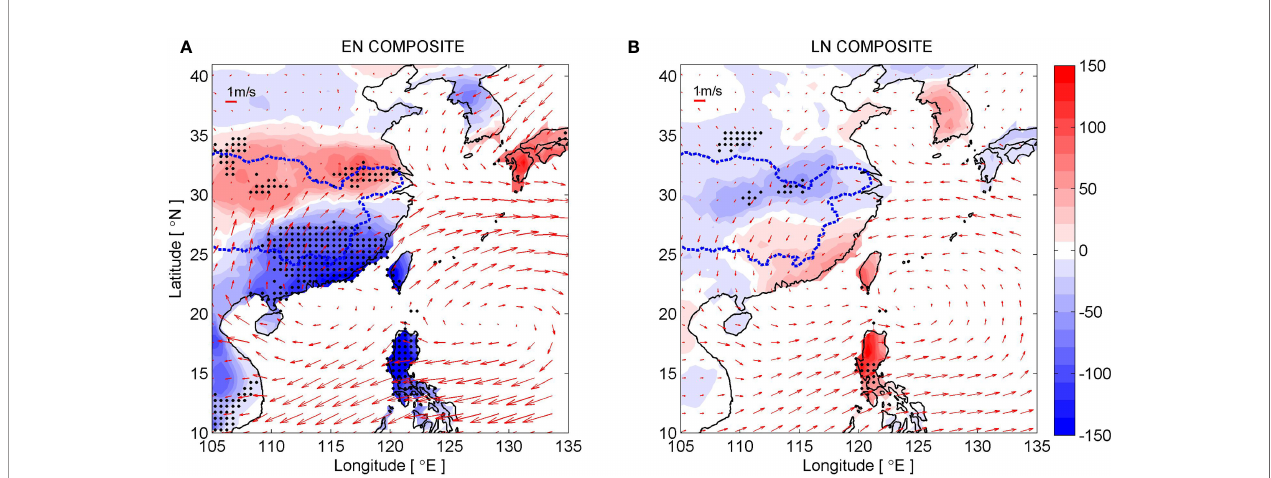
FIGURE 7 | (A) Composite difference of land-based precipitation (color) in July for fi ve El Niño years (1998, 2003, 2005, 2007, and 2010) and the climatology mean. Red arrows denote composite difference of surface wind between El Niño years and climatology mean. Stippling indicates that the differences are statistically signi fi cant at the 95% level. The region bounded by a thick blue dashed line denotes the Changjiang river catchment. (B) is the same as (A) , but for eight La Niña years (1999, 2000, 2001, 2006, 2008, 2009, 2011, and